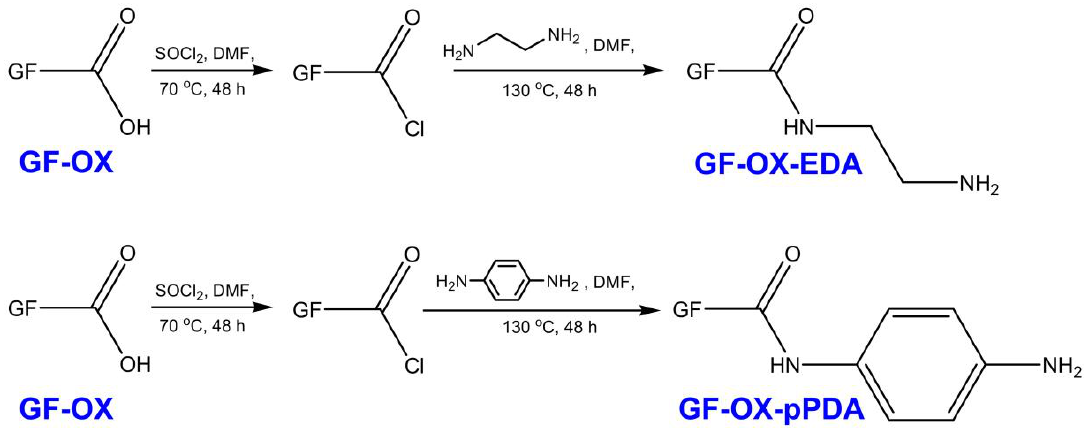
Figure 4. Reaction scheme of two step modification (Method B) of electrochemically oxidized graphite felt (GF-OX) with ethylenediamine and p -phenylenediamine.